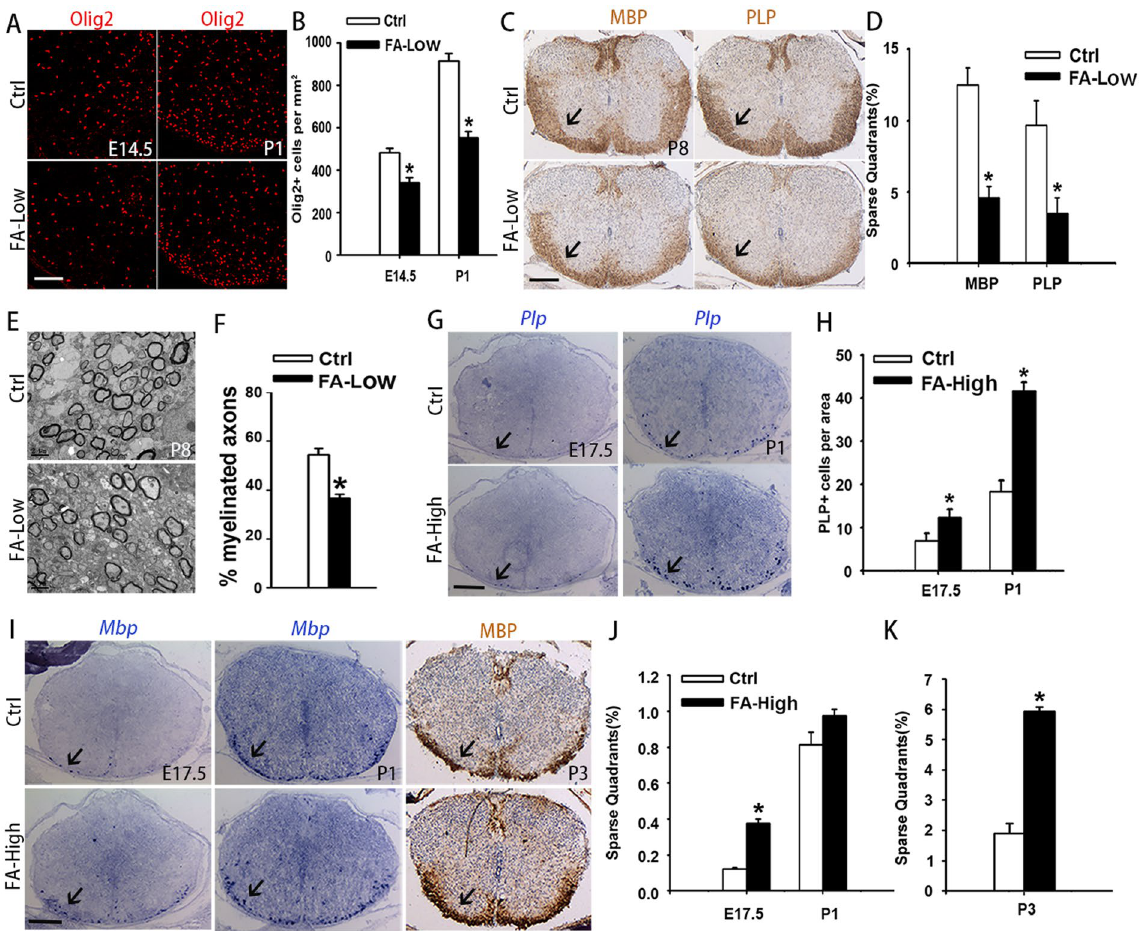
Figure 1. Folate promotes the development of oligodendrocytes in vivo . ( A ) Spinal cord isolated from control and FA-Low mice stained with Olig2 antibody at E14.5 and P1. The ventral parts showed in the images. ( B ) Quantification of the numbers of Olig2 + cells per mm 2 in ventral part of spinal cords of ( A ) is shown in ( B ). Data represents the mean ± S.D. (n = 5, * p < 0.05 compared with control, student’s t test). ( C ) Immunohistochemistry analysis of spinal cords isolated from normal folate-supplemented diet (2 mg folate/ kg diet, Ctrl) or low folate-supplemented diet (0.2 mg folate/kg diet, FA-Low) mice stained with MBP and PLP antibodies at P8. ( D ) The number of quadrants with sparse staining for MBP and PLP of ( C ) scored and expressed as a percentage of the total number of quadrants. (n = 5, * p < 0.05 compared with control, student’s t test). ( E , F ) Electron micrographs of spinal cords from control and FA-Low mice at P8. ( F ) Shows the percentage of myelinated axons. Data represent the mean ± S.E.M. from three animals ( * p < 0 . 05 compared with control, student’s t test). ( G , I ) In situ hybridization and immunohistochemistry analysis of PLP and MBP on the Spinal cord isolated from E17.5, P1, P3 control and FA-High mice. Arrows point to the white matter. ( H ) Quantification of the numbers of PLP + cells per area (one section of spinal cord) in spinal cords of ( G ) is shown in ( H ). Data represent the mean ± S.D. (n = 5, * p < 0 . 05 compared with control, student’s t test). ( J , K ) The number of quadrants with sparse staining for MBP of ( I ) scored and expressed as a percentage of the total number of quadrants. (n = 5, * p < 0 . 05 compared with control, student’s t test). Scale bars: 100 μ m ( A ), 200 μ m ( C,G,I ), 2 μ m ( E